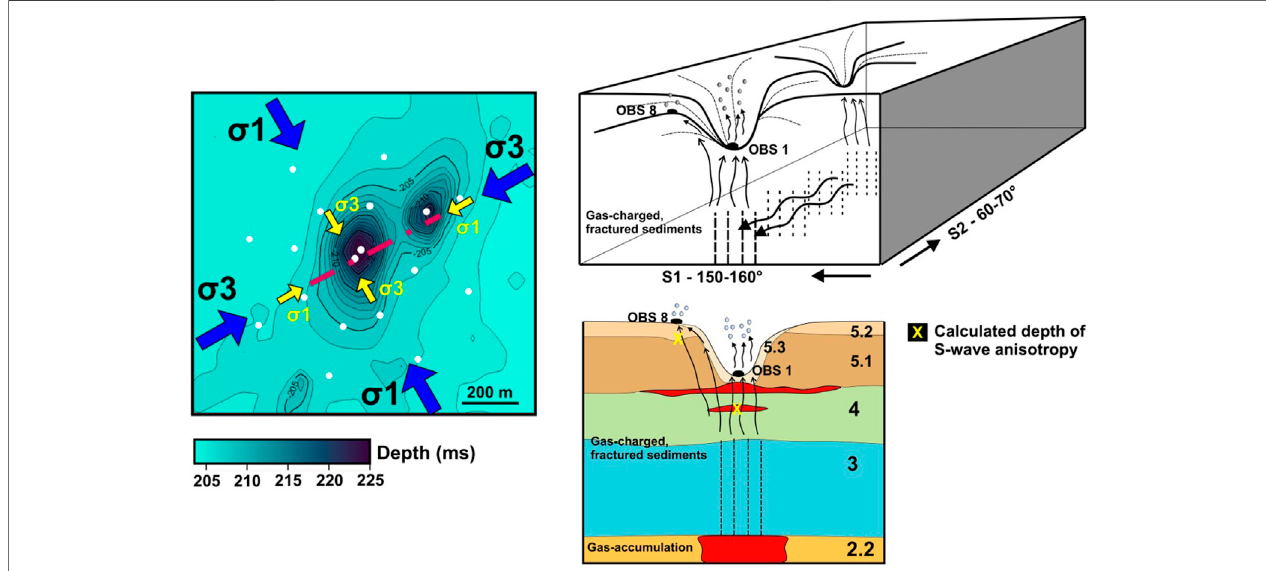
FIGURE 14 | Schematic diagram illustrating open gas migration pathways beneath Scanner pockmark that generate the shear-wave splitting observed on OBS1 and 8. Bottom right: Gas accumulations are present in S2.2, S4, and at the S4/S5.1 interface, indicated in red. Reference to color of seismic units S1-S5 found in Figure 3 . Left: Blue arrows show regional maximum ( σ 1) and minimum ( σ 3) horizontal stress. Yellow arrows show local stress conditions caused by high pore fl uid pressure. Red dashed line shows orientation of gas observed in Figures 11C,D . OBS locations shown in white. Top right image: S1 and S2 are the fast and slow S-wave directions,